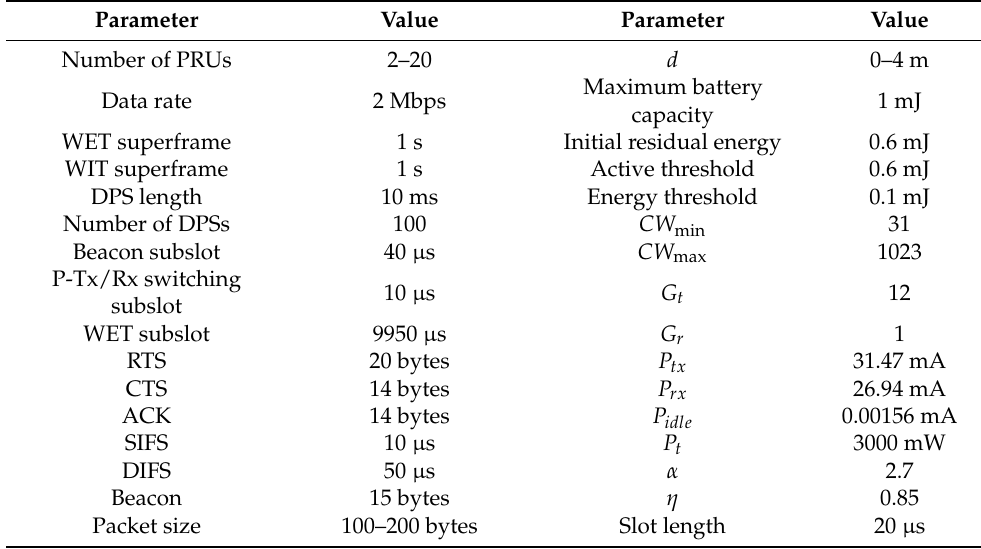
Table 1. Simulation